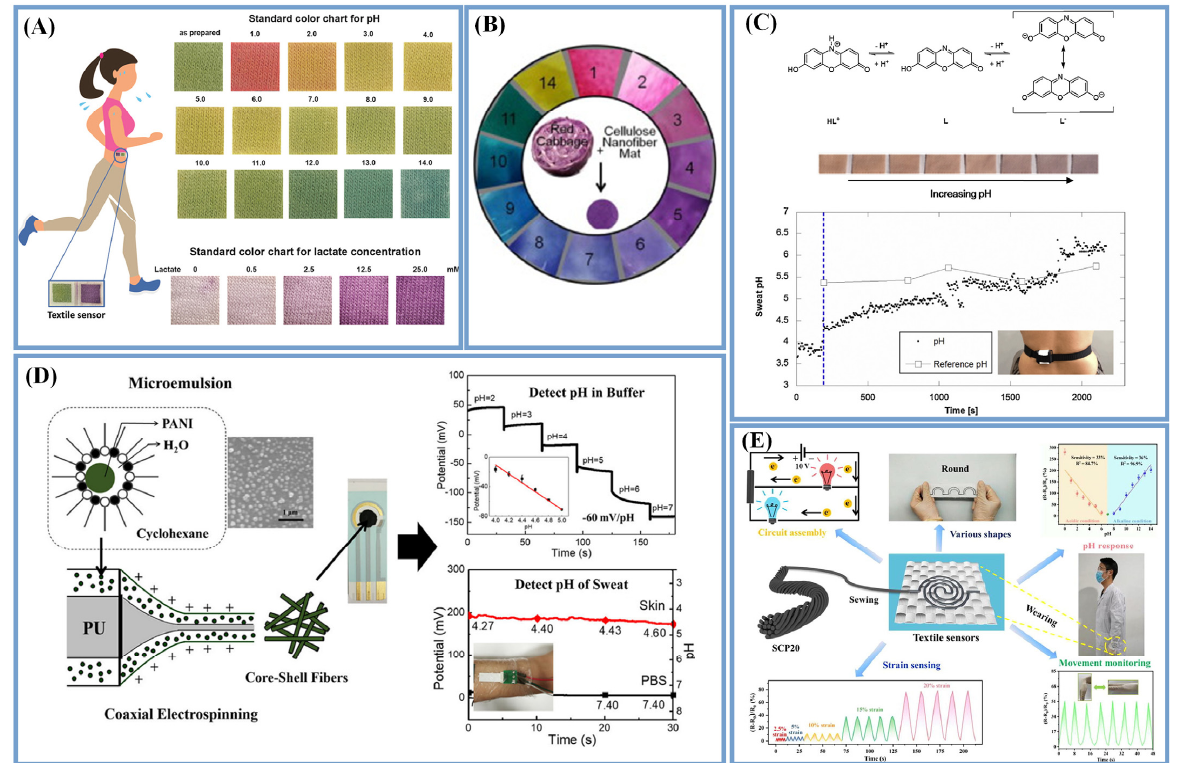
Figure 5. pH sensors based on different detection methods. ( A ) pH values between 0 and 14 could